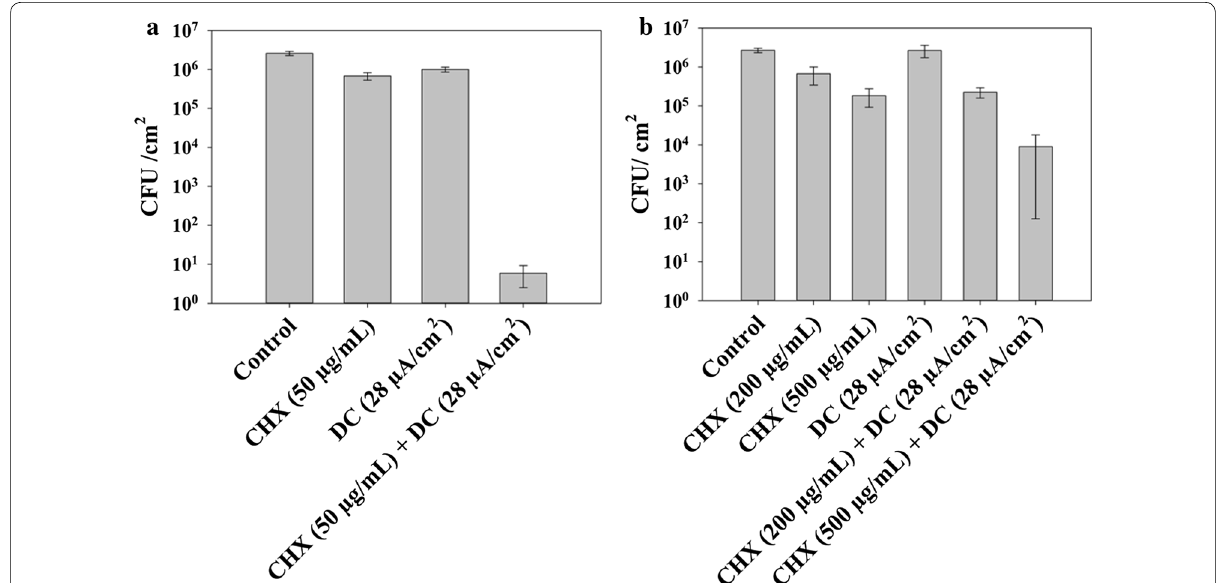
Fig. 3 Viability of S. aureus biofilm cells after treatment with CHX, DC, or concurrent treatment. a Treatment in 0.85% NaCl. DC level: 28 µA/cm 2 . CHX